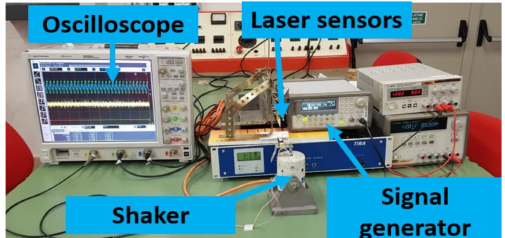
Figure 2. Experimental setup, showing the shaker used and related driving system (Signal generator and amplifier), the laser sensors for the composite deflection estimation, and the oscilloscope, for the recording of signals produced both by the laser sensors and by the mechanoelectrical BC- based